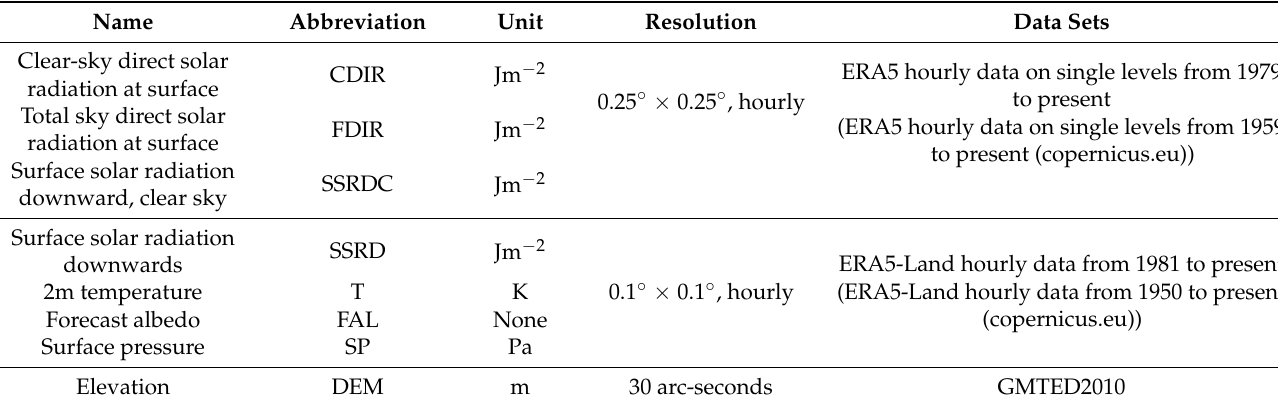
Table 1. Summary of input data for the PV_LIB